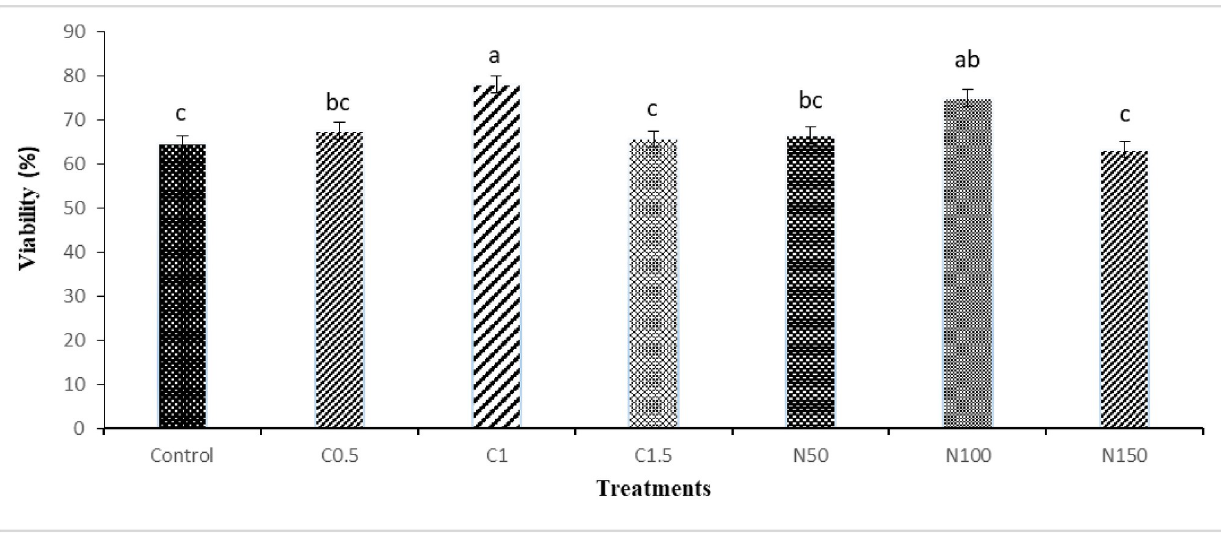
Fig 3. Effect of crocin and naringenin supplementation in cryopreservation medium on post thawed viability (%, eosin-nigrosine method) of rooster sperm. Beltsville extender without antioxidant (control), C0.5 (Beltsville extender with 0.5 mM crocin), C1 (Beltsville extender with 1 mM crocin), C1.5 (Beltsville extender with 1.5 mM crocin), N50 (Beltsville extender with 50 μ M naringenin), N100 (Beltsville extender with 100 μ M naringenin), N150 (Beltsville extender with 150 μ M naringenin).